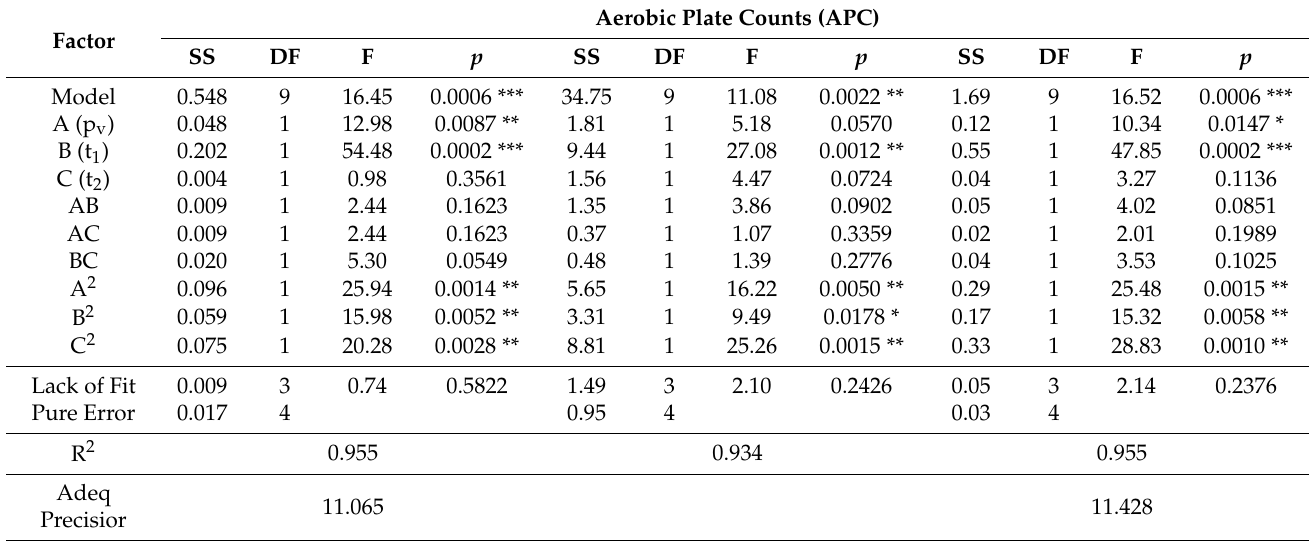
Table 7. Analysis of variance for the parameter estimations obtained from multiple linear regression and for the lack-of-fit test for p v , t 1 , and t 2